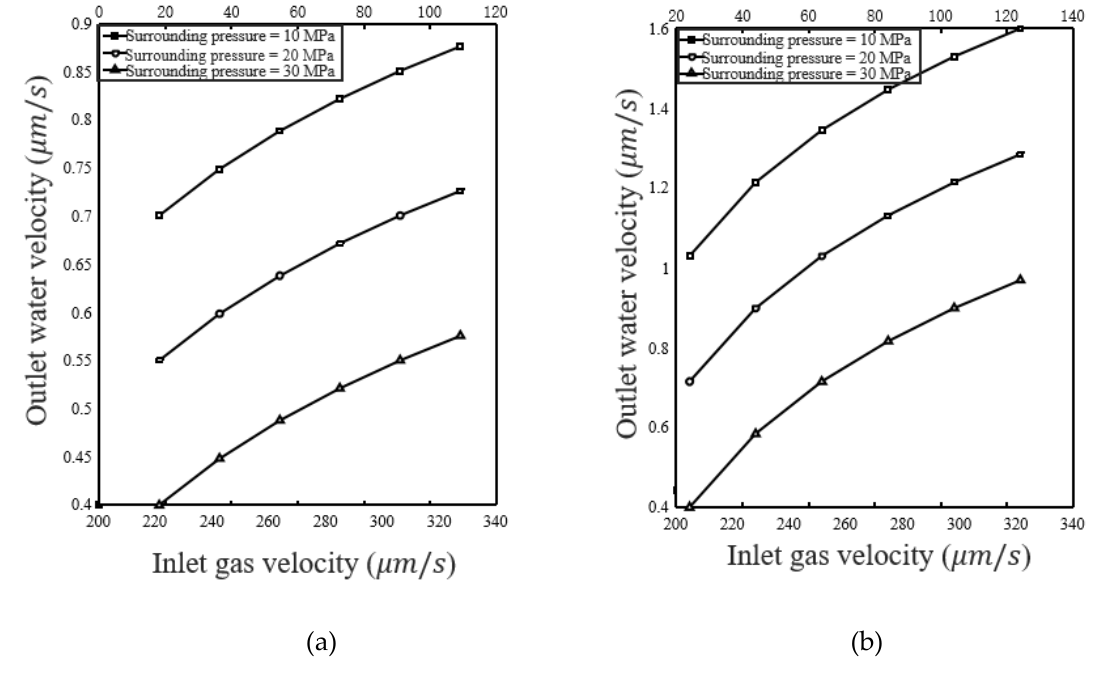
influence of the pore – vug – fracture structure, causing the nonlinearity of the